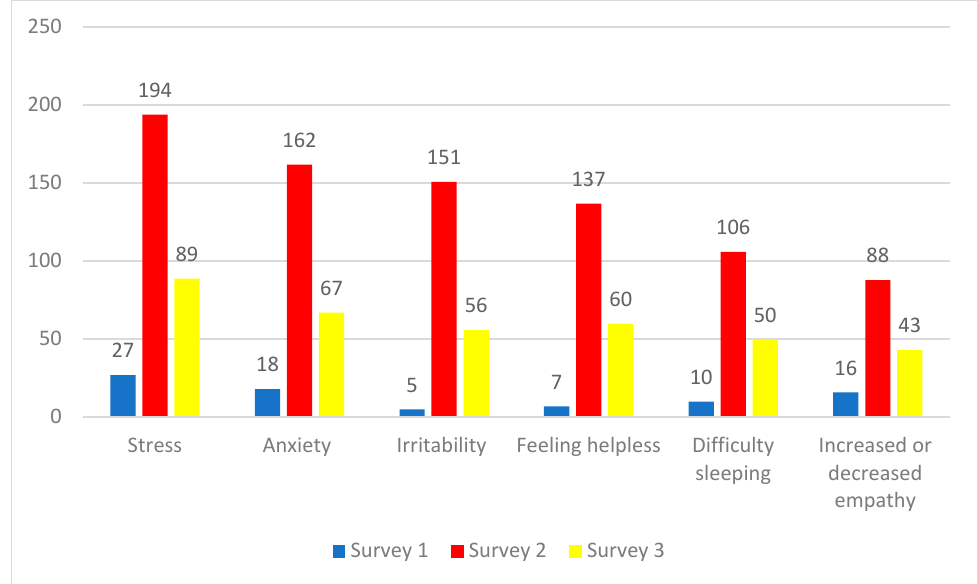
Figure 6. Number of responses on the impact of moral distress. Since participants could select multiple themes, it is not possible to calculate percentages.